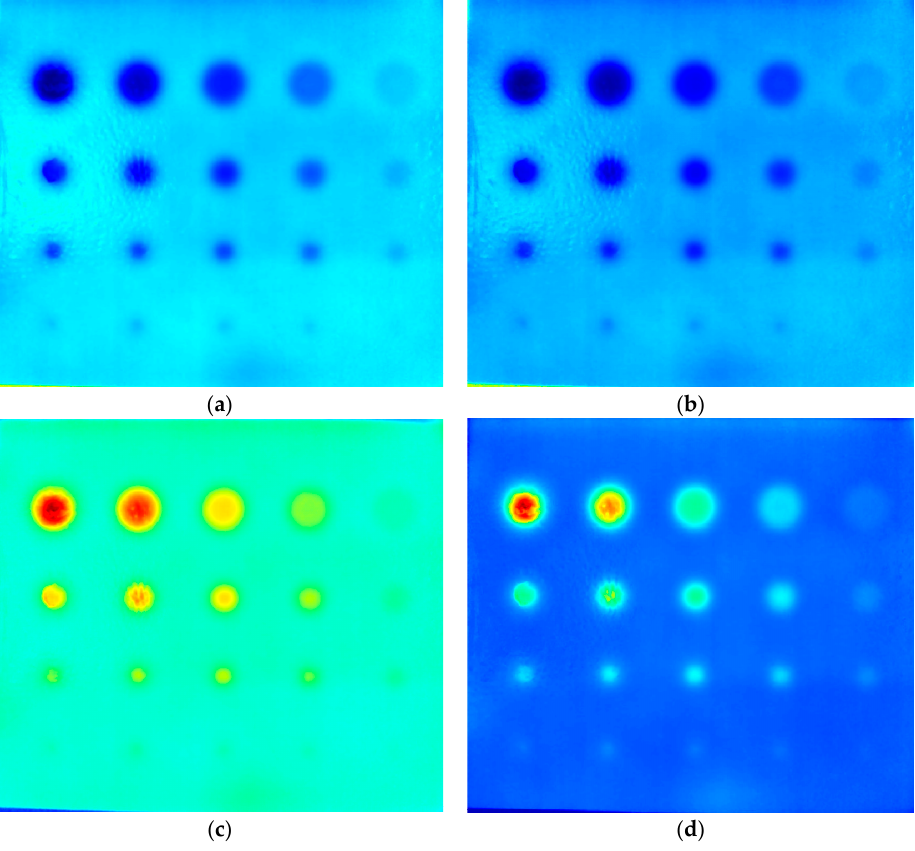
Figure 7. Four matched filters including ( a ) Spectral Angle Map (SAM), ( b ) Adaptive Coherence Estimator (ACE), ( c ) t -statistic and ( d ) F -statistic when the specimen was being step